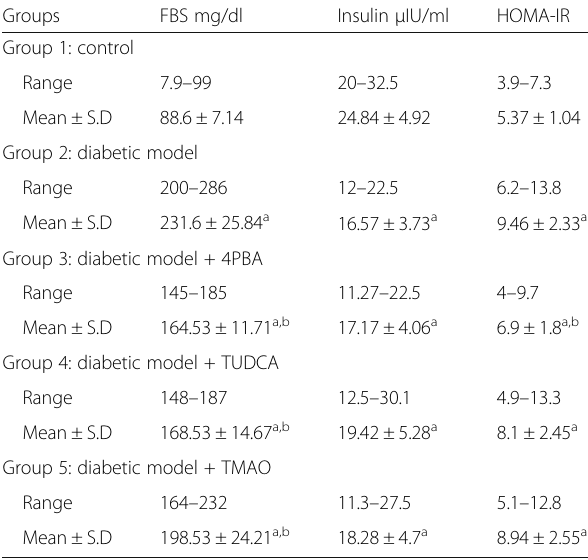
Table 2 Study of plasma fasting blood sugar (FBS), serum insulin, and resistance (HOMA-IR) in control and experimental groups